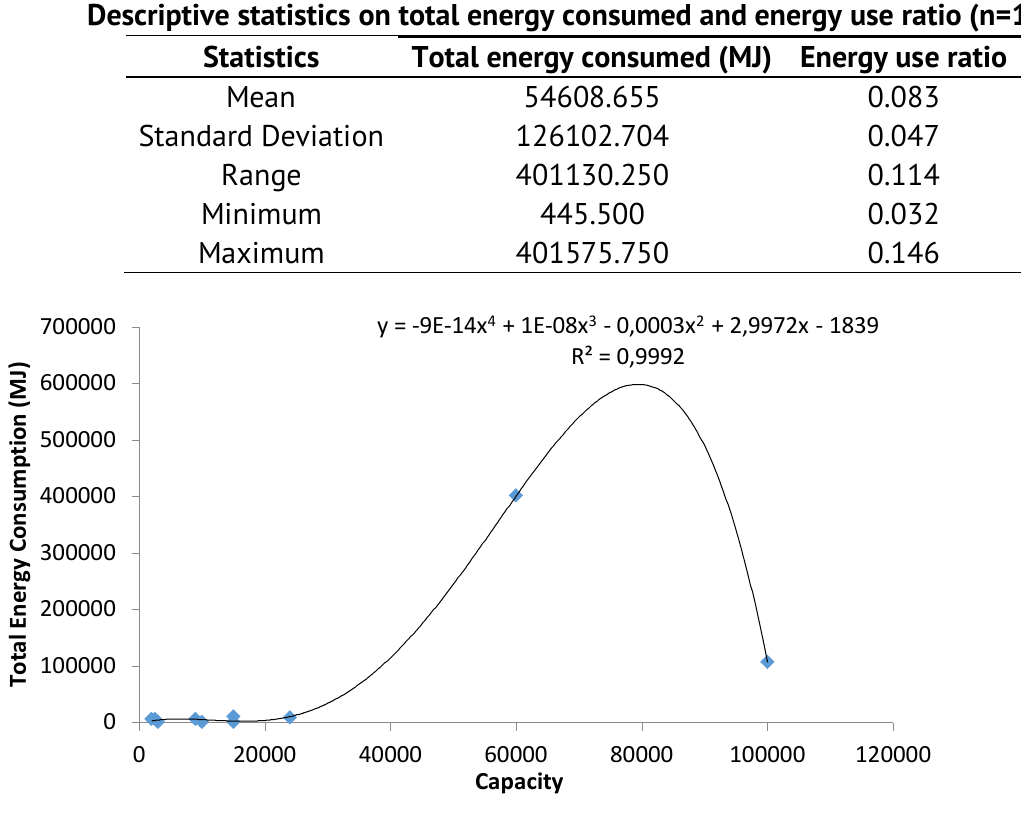
Figure 4. Total energy consumed versus poultry capacity.